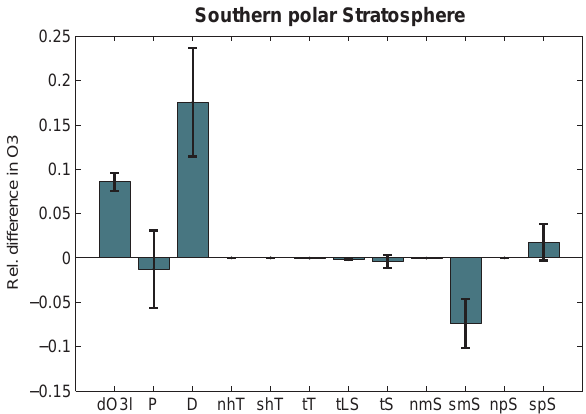
Fig. 11. As in Fig. 10 but for the southern polar stratosphere only and with the changes due to import split up into import from each region (the region labels correspond to those in Table 1) .